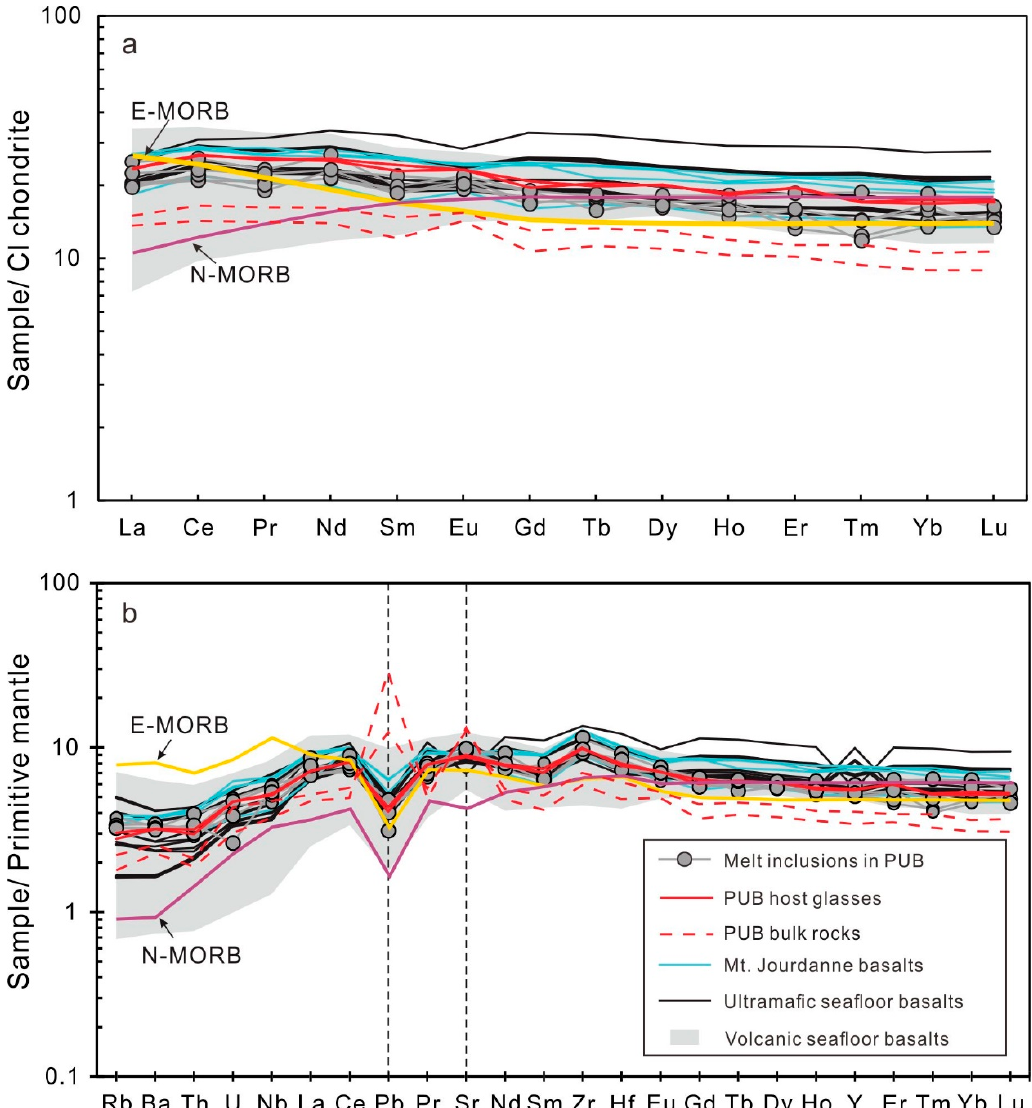
Figure 4. ( a ) Chondrite normalized rare earth element (REE) and ( b ) primitive mantle normalized trace element patterns for Mount Jourdanne basalts and plagioclase-hosted melt inclusions. Literature data for the basalts from the volcanic and ultramafic seafloor, SWIR (61–67° E) are plotted for comparison [30]. Primitive mantle, average N-MORB and E-MORB data from Sun and McDonough [46]. Chondrite normalized values from McDonough and Sun [47].